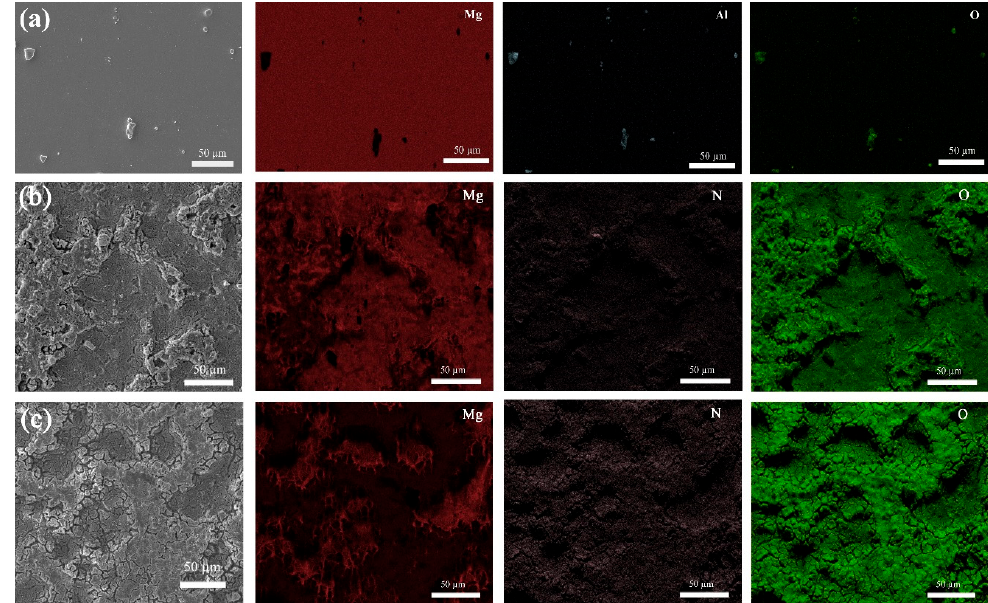
Figure 1. The SEM micrographs and relative elemental mapping of ( a ) the as-received AZ31 alloy; (b ) “dopa” and ( c ) “dopa-O”. Samples functionalized via dopamine with the absence of oxygen are designated as “dopa”, while samples immersed in a solution rich in oxygen are named “dopa-O”.